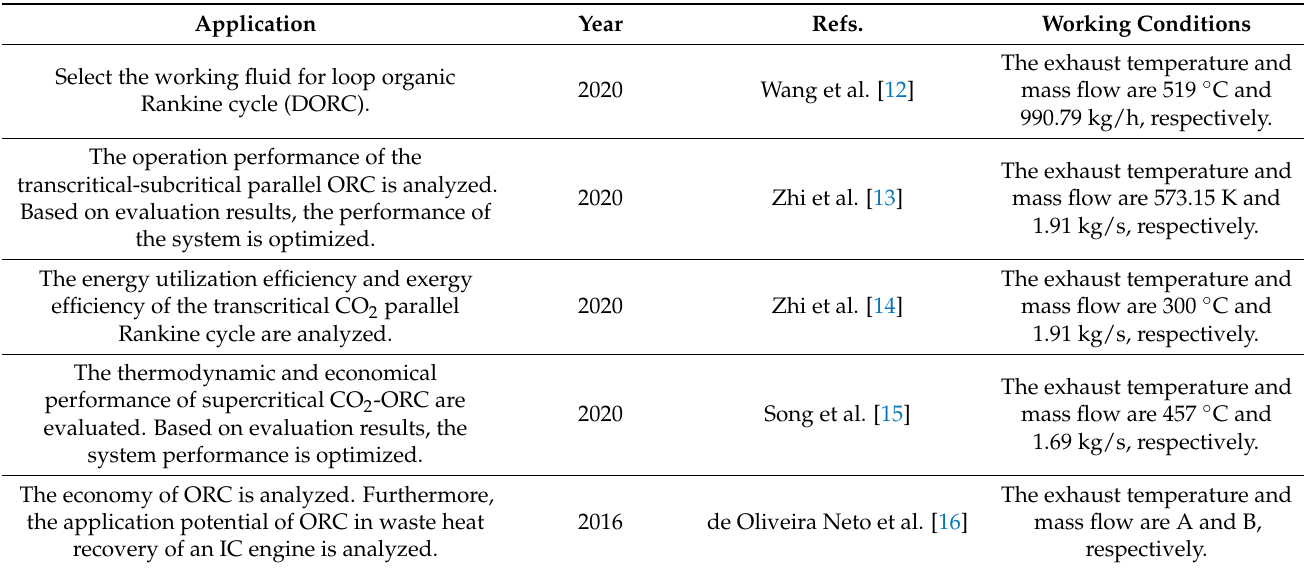
Table 1. Selection of working environments of an IC engine.